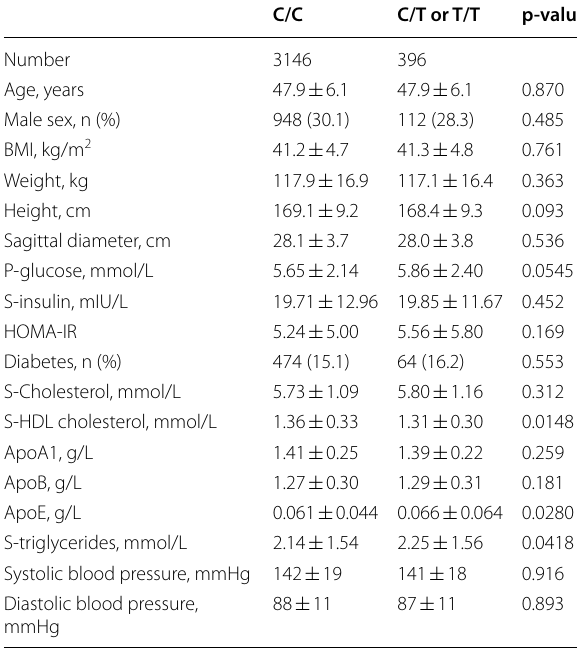
Table 2 Patient characteristics in the SOS